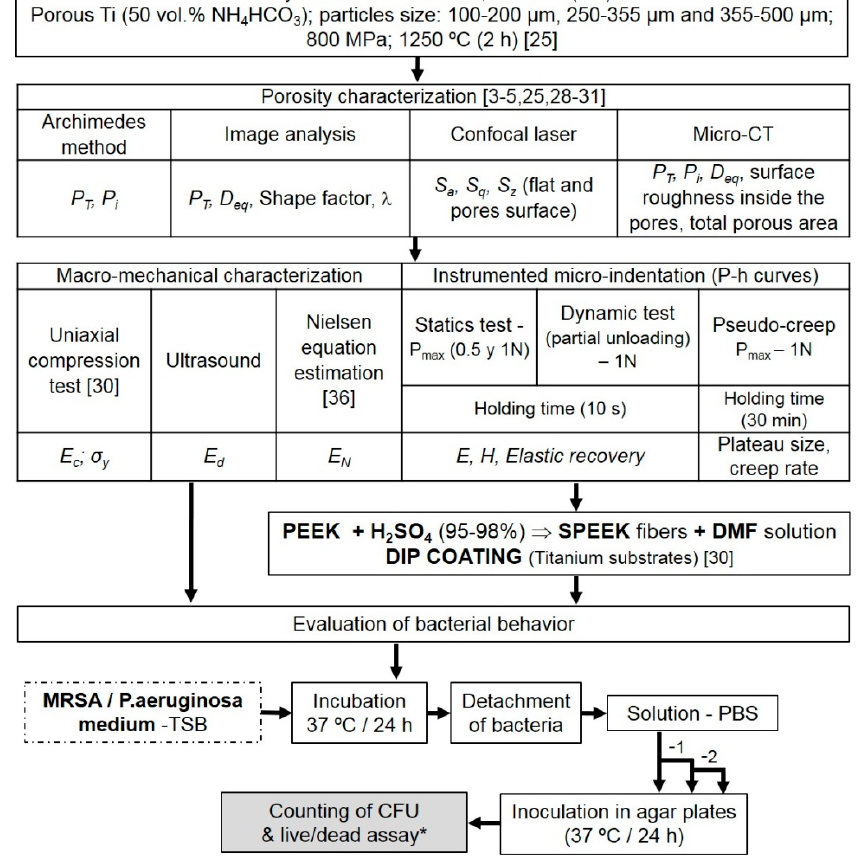
Figure 1. Diagram showing the fabrication, characterization and bacteria designed experiments of uncoated and coated with sulfonated polyetheretherketone (SPEEK) on porous commercially pure titanium (c.p. Ti) substrates. * Note: A live–dead assay was only performed on the studies with methicillin-resistant Staphylococcus aureus (MRSA).